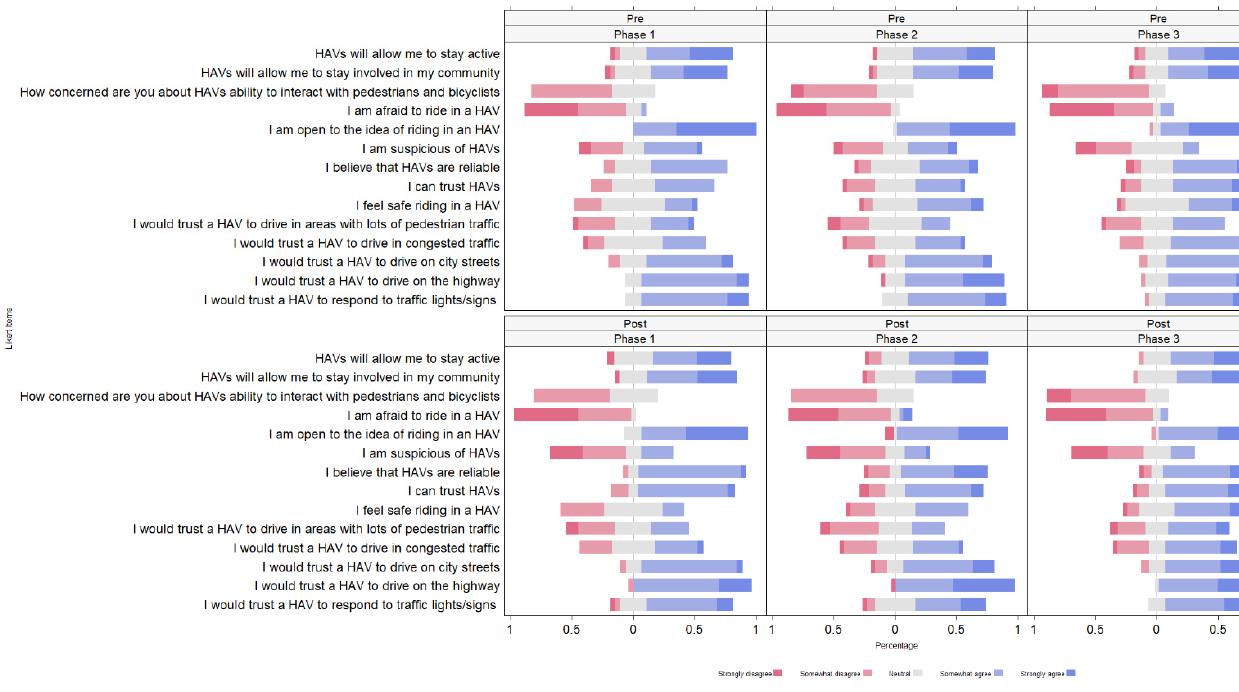
Figure 4. Diverging bar chart displaying the perceptions of HAVs before and after riding in the shuttle between phases. Table 2. Perceptions of HAVs before and after riding in the AV by phase.